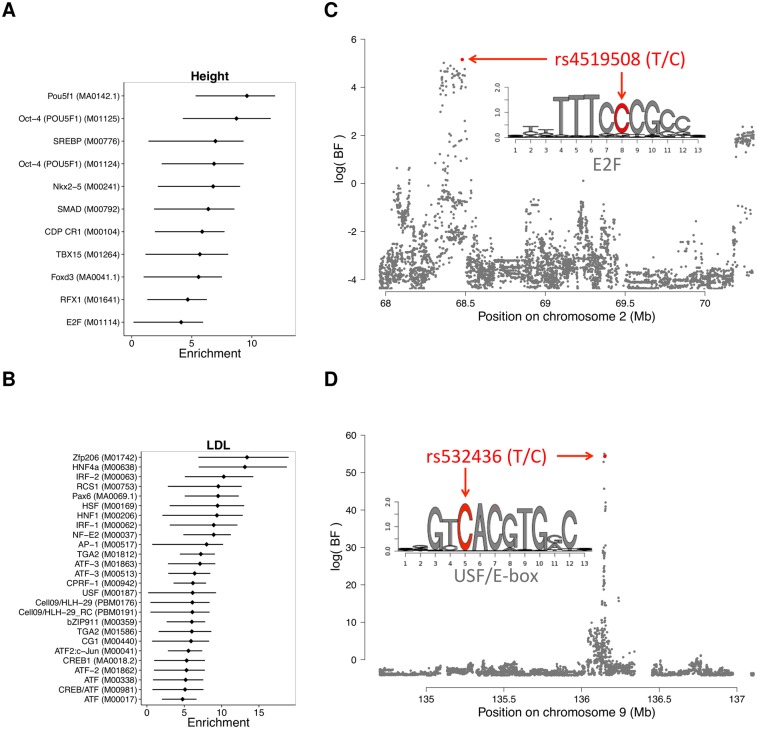
Integration of annotations into GWAS results.(A & B) Enrichment (log2(change in prior odds w.r.t the baseline model)) of factors for association with (A) height and (B) low-density lipoprotein levels. Error bars are drawn for 95% confidence intervals. (C & D) Association plots showing the Bayes factor of each SNP in the displayed region for (C) height and (D) low-density lipoprotein levels. Shown in red are SNPs with a posterior probability of association >0.4.